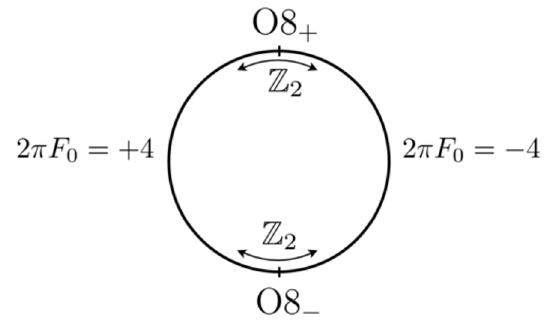
Figure 1 . A picture taken from [1] describing the intenrnal topology of the CDLT 1 solutions. Here l s = 1